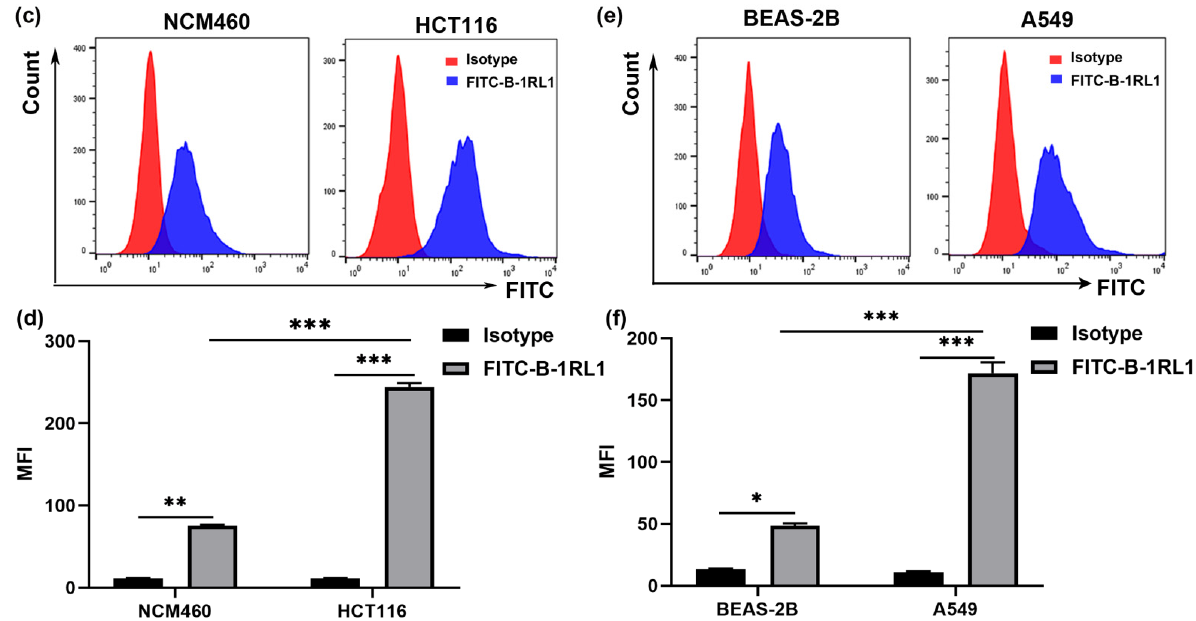
Figure 5. Brevinin-1RL1 localization and binding affinity in tumor cells. Location of Brevinin-1RL1 in NCM460 and HCT116 cells ( a ), BEAS-2B and A549 cells ( b ). Cells were seeded on glass-bottom 6-well plates and treated with FITC-labeled Brevinin-1RL1 for 12 h. Then, the FITC-B-1RL1 was traced and recorded using laser scanning confocal microscopy. ( c ) The binding affinity of Brevinin-1RL1 in NCM460 and HCT116 cells ( c ), BEAS-2B and A549 cells ( e ). 1 × 10 6 /mL HCT116, NCM460, A549 and BEAS-2B cells were collected and incubated with FITC-B-1RL1 or an equal dose of FITC Isotype as controlin the dark for 1 h. Fluorescence alteration was detected by flow cytometry. ( d ) The MFI (Median Fluorescence Intensity) value was statistics from ( c ). ( f ) The MFI value was statistics from ( e ). * p < 0.05, ** p < 0.01 and *** p < 0.001 in comparison to negative controls (Isotype), and indicated the significant difference between the two groups. Data expressed as the mean ± SD ( n =